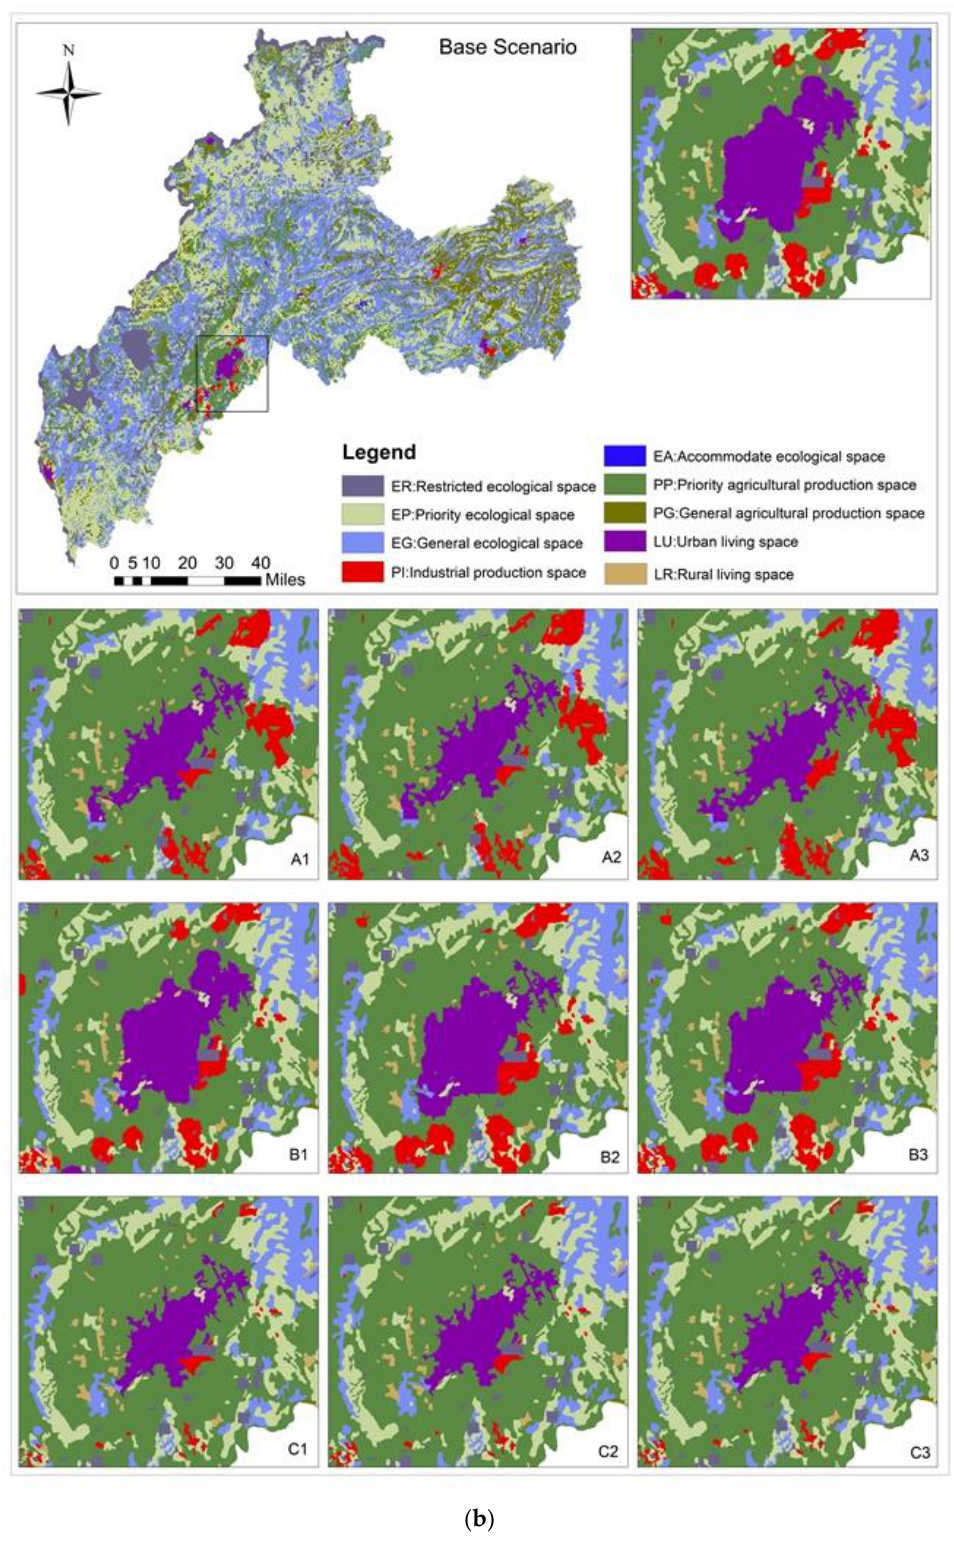
Figure 8. Spatial distribution of PLE space in different scenarios:( a ) represent eastern region;( b ) represent central region. And A1 – C3 represent differen scenarios.